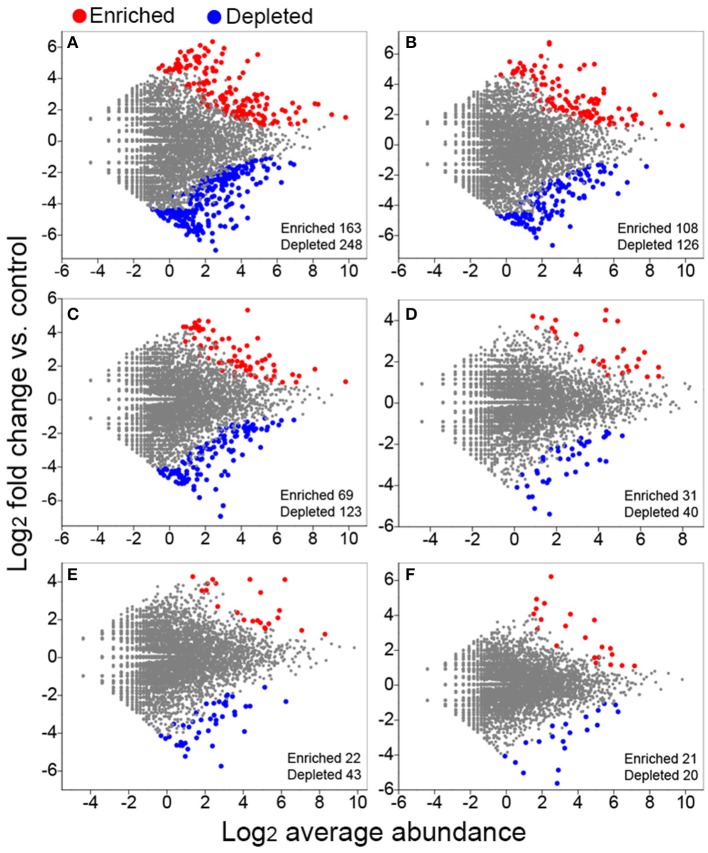
Volcano plots illustrating OTUs significantly enriched (red) and depleted (blue) by long-term fertilization compared with unfertilized control as determined by differential abundance analysis. Each point represents an individual OTU, and the Y axis indicates the abundance fold change vs. unfertilized control. (A) MNPK (manure plus NPK) vs. control; (B) SNPK (straw plus NPK) vs. control; (C) HNPK (high rate of N, regular PK) vs. control; (D) LNPK (low rate of N, regular PK) vs. control;(E) NP vs. control; (F) NK vs. control.